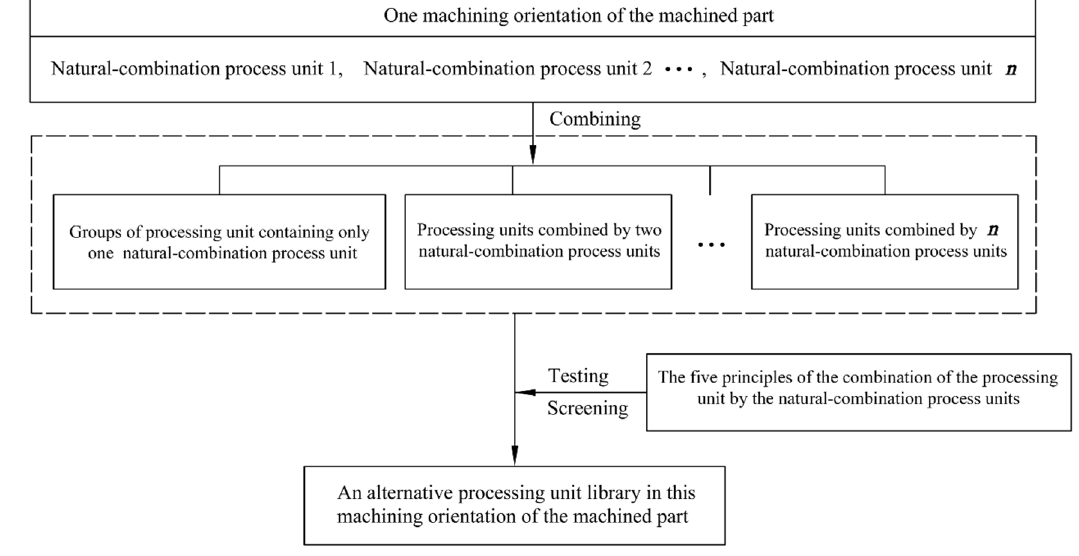
Figure 9. Flow chart for establishing an alternative processing unit library of a machined part in one machining orientation.